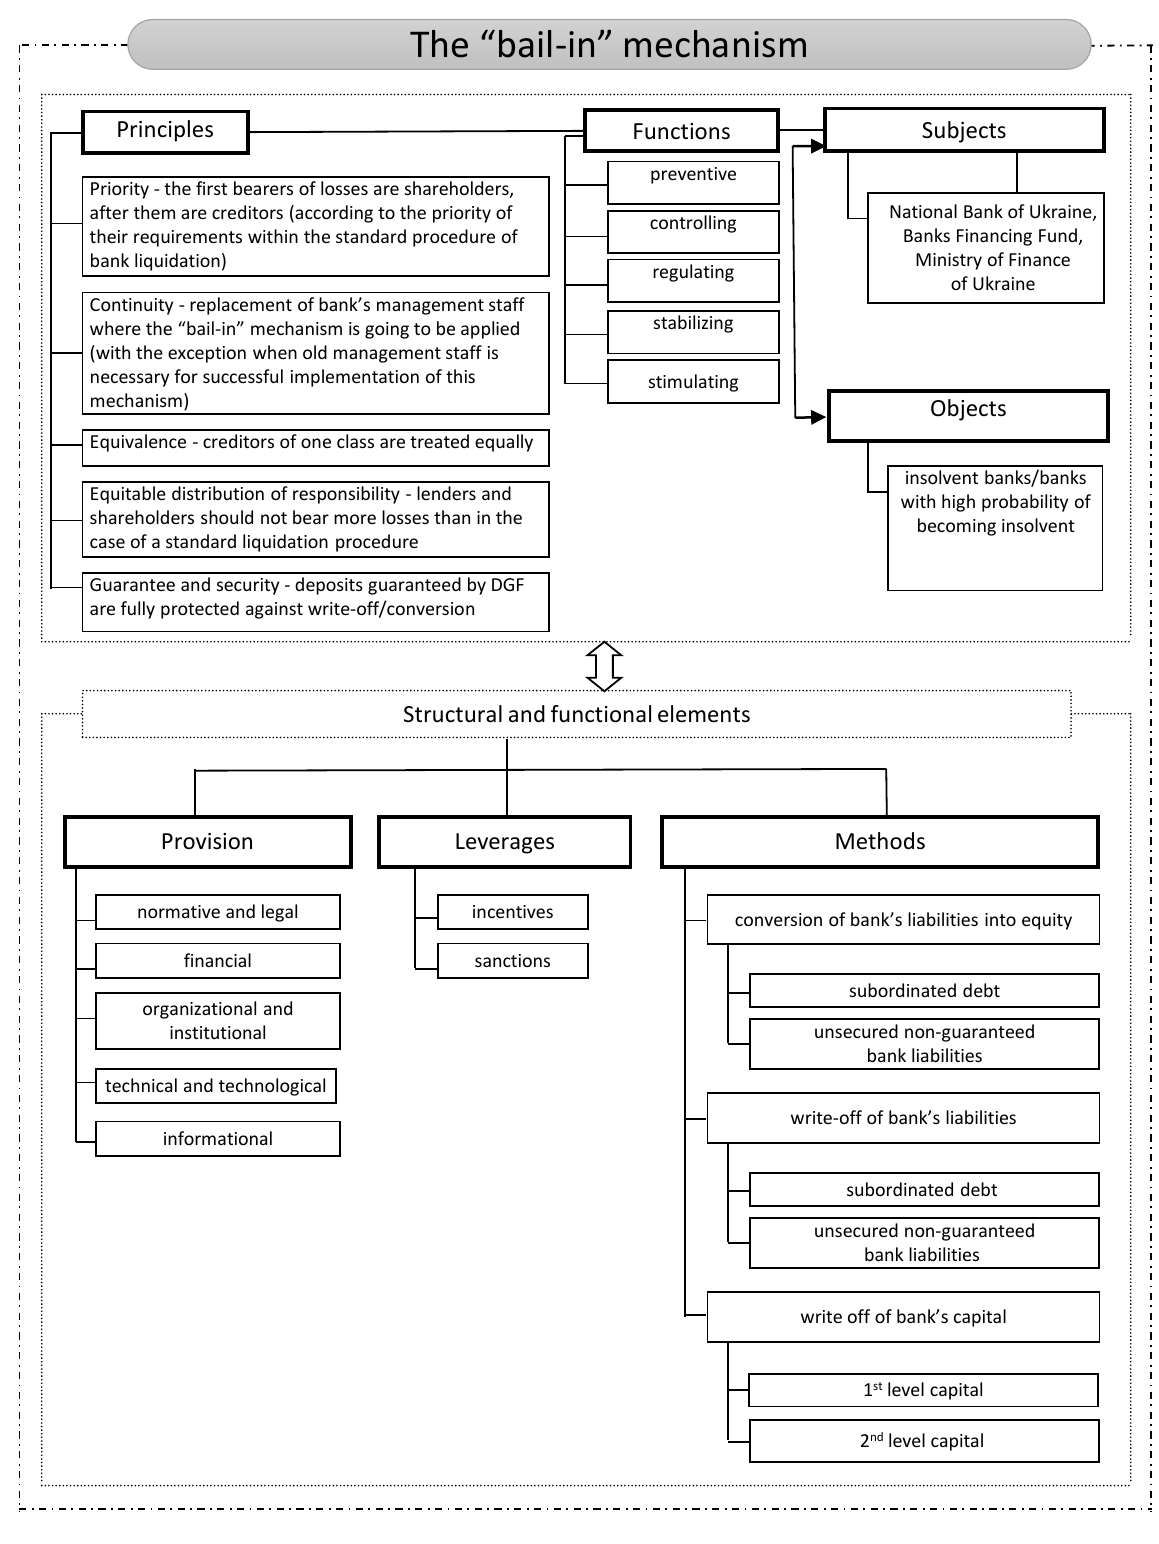
Figure 1. The structure of the “bail-in”